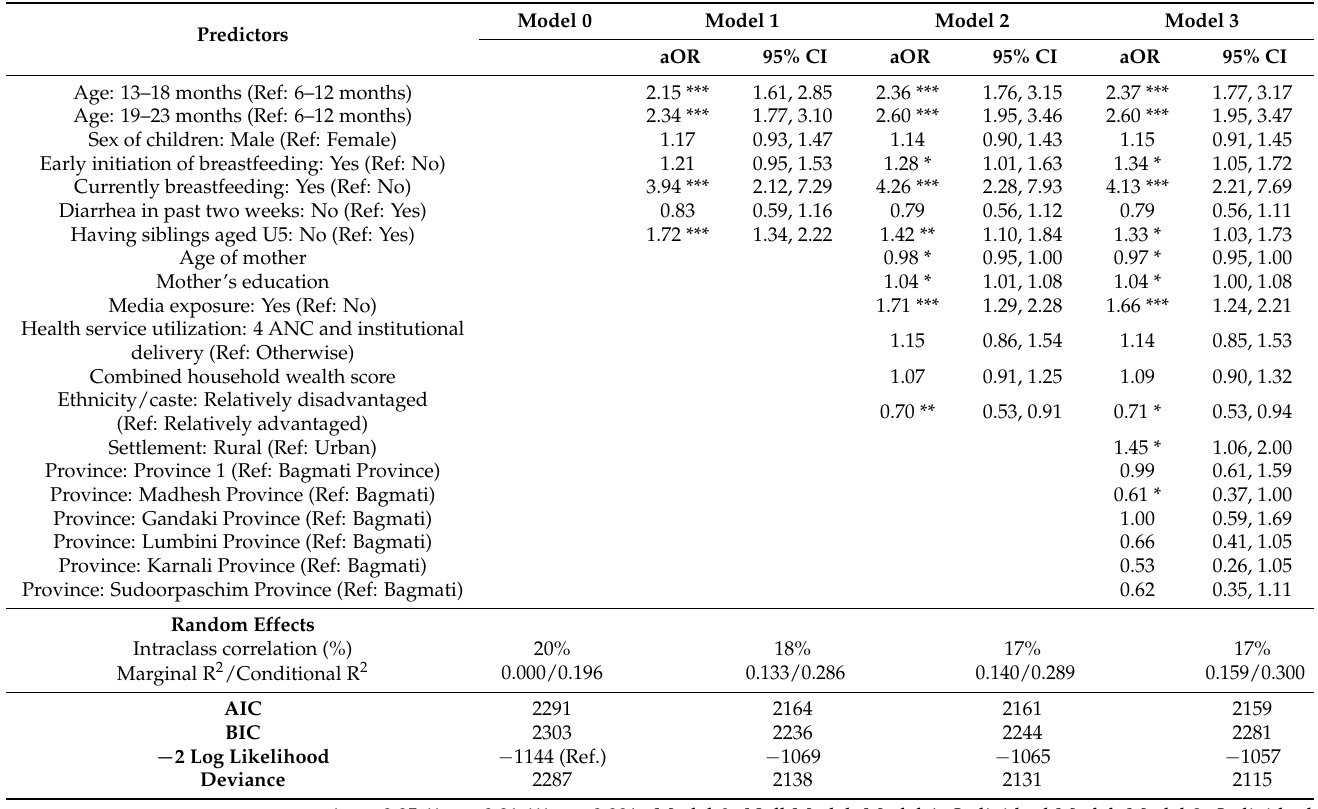
Table 4. Multilevel analysis for predictors of minimum acceptable diet among children aged 6–23 months in Nepal.